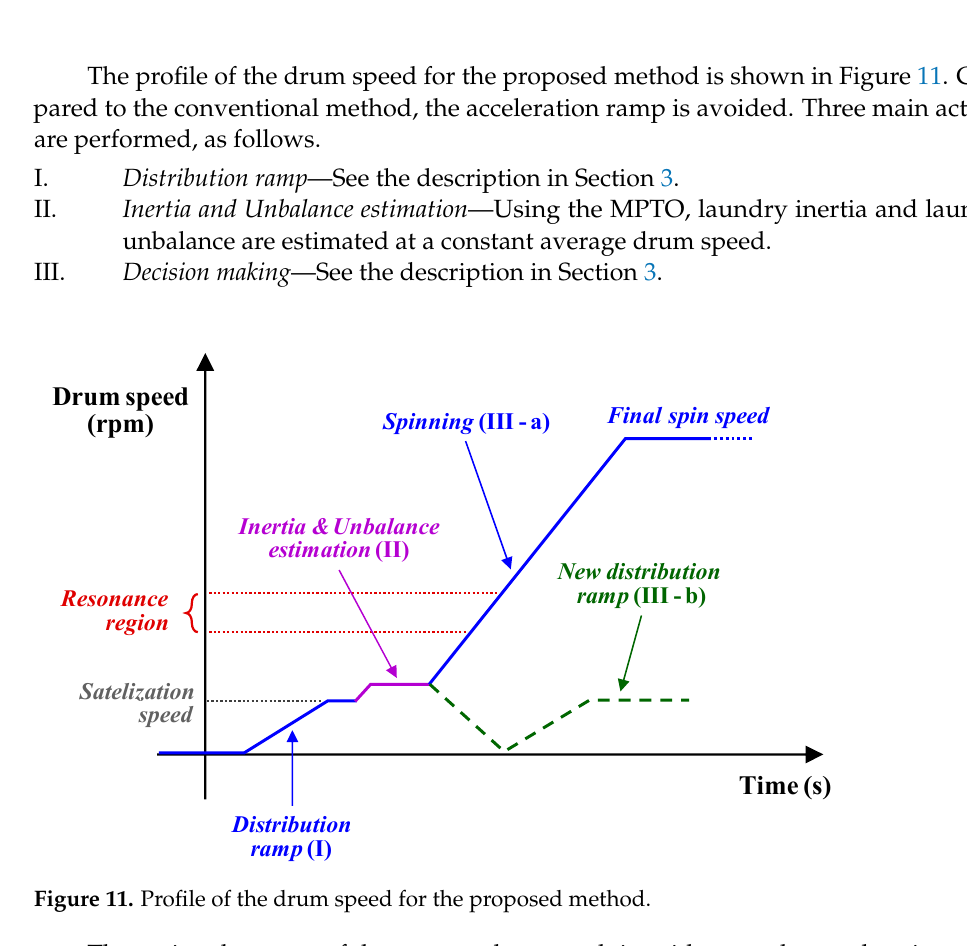
Figure 10. Example of MPTO integration on a sensorless field-oriented control scheme for wash- ers.